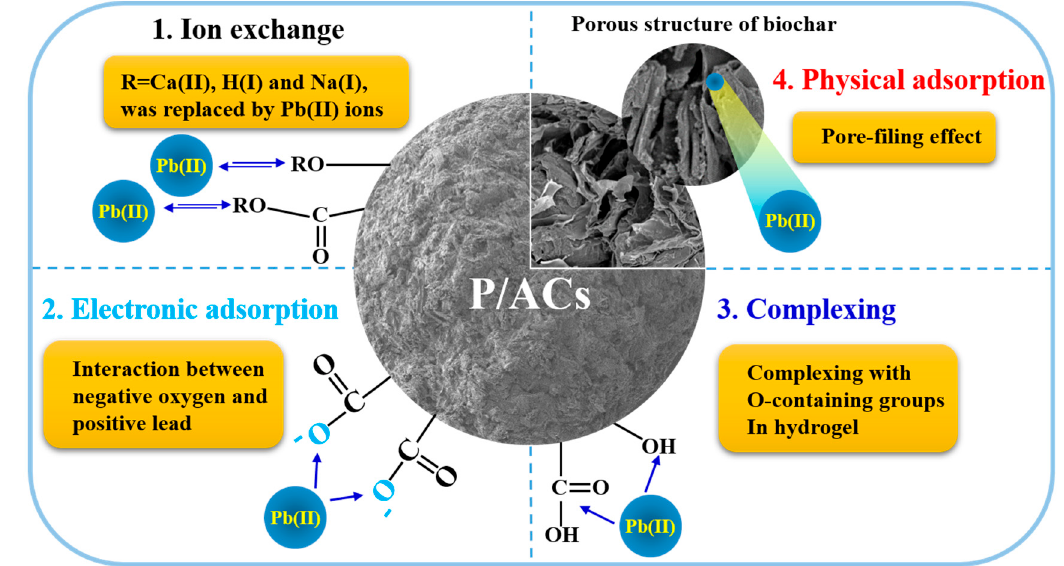
Figure 10. The proposed mechanisms of adsorption of Pb 2+ by P/ACs.